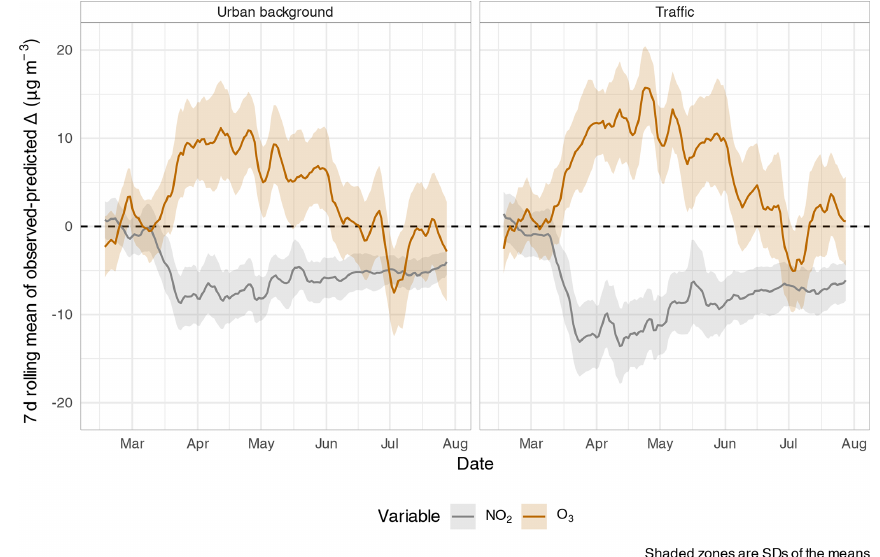
Figure 4. The 7d rolling means of the observed–predicted concentrations’ deltas for NO 2 and O 3 for all European sites analysed between 14 February and 31 July